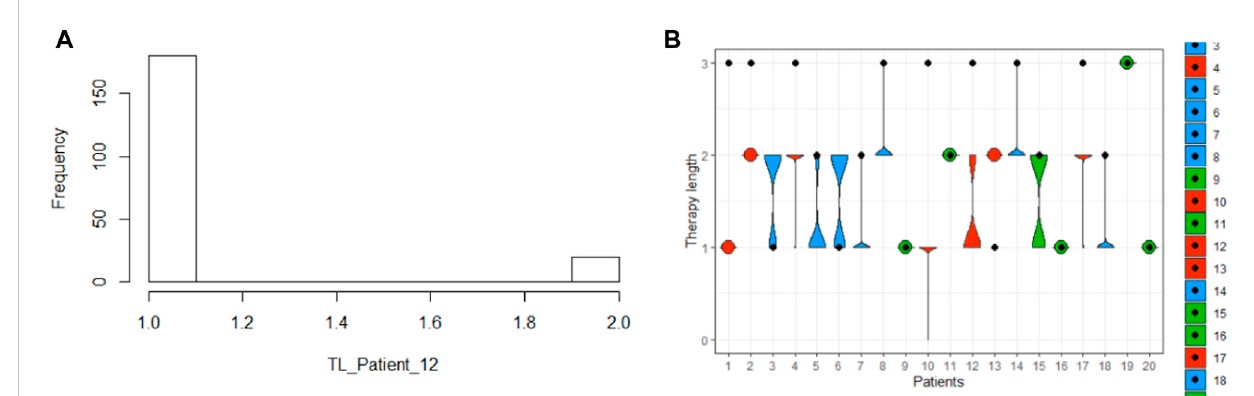
FIGURE 6 Precision of the prognosis of the therapy length for one patient with an ambiguous output (A) , and for a patient cohort (20 patients) in the whole populationwithvalidationresults:greenisaperfectprognosis,blueisaby-prognosisthatisstillful fi lledinsidetheuncertaintyoftheprediction,andredis an off-prognosis. The black points are the